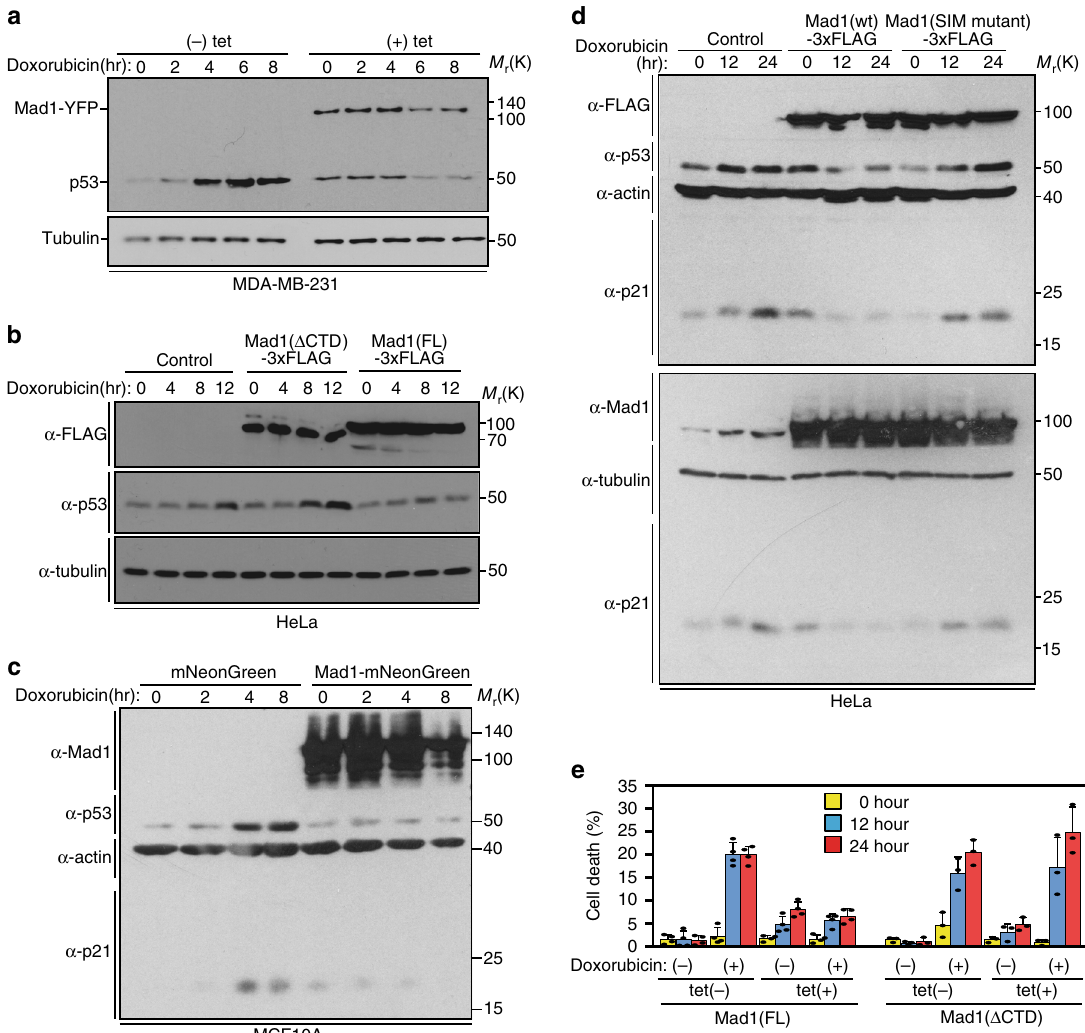
Fig. 4 Mad1 upregulation destabilizes p53 and impairs cell death in response to DNA damage. a MDA-MB-231 cells stably expressing Mad1-YFP in response to tet were treated ± tet for 24 h and then with the topoisomerase II inhibitor doxorubicin (2 µ g/mL) to induce DNA damage for the indicated times. Blot is representative of 3 independent experiments. b The CTD of Mad1 is essential for its role in preventing stabilization of p53. HeLa cells stably expressing full length (FL) Mad1-3xFLAG or Mad1 lacking the CTD (aa 1 – 596) in a tet-inducible manner were treated with tet for 24 h and then with doxorubicin (2 µ g/mL) for the indicated times. Blot is representative of 3 independent experiments. c MCF10A cells were infected with adenoviruses expressing mNeonGreen or Mad1-mNeonGreen for 1 h and then treated with 1 µ g/mL doxorubicin to induce DNA damage for the indicated times. Expression of Mad1-mNeonGreen prevents stabilization of p53 and its downstream effector p21. d The SIM in the CTD of Mad1 is necessary for Mad1 to prevent stabilization of p53 and p21. HeLa cells stably expressing tet-inducible wild type Mad1-3xFLAG or Mad1-SIM mutant-3xFLAG were treated with tet for 24 h and then with 2 µ g/mL doxorubicin for the indicated number of hours. Wild type Mad1 but not SIM mutant Mad1 prevents stabilization of p53 and p21. Blot is representative of 3 independent experiments. e Quantitation of cell death (±SD) in HeLa cells stably expressing tet-inducible 3xFLAG tagged full length or Δ CTD Mad1 ± 24 h tet, then ±2 µ g/mL doxorubicin for 0, 12, and 24 h. Full length Mad1, but not Mad1 lacking the CTD, prevented cell death due to DNA damage. n > 250 cells from each of 3 independent